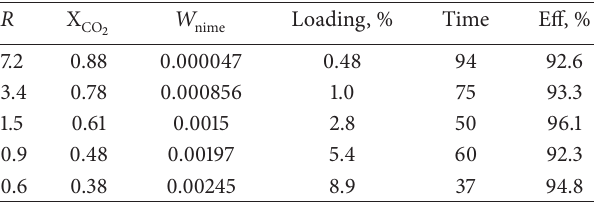
Table 1: Adsorption data of nimesulide on silica aerogel at different /EtOH weight ratio ( 𝑅 ). 𝑊 is the mass fraction values of the CO 2 nime of nimesulide in the solution, time is the duration of the experiment